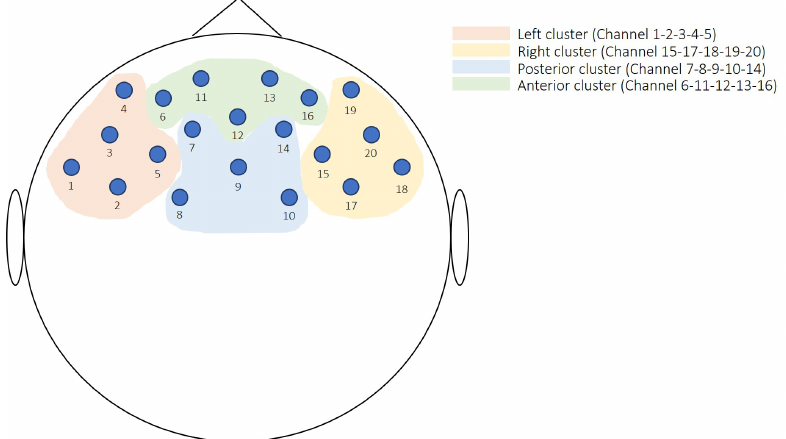
Figure 1. Diagram displaying channel locations and clusters of channels used in the